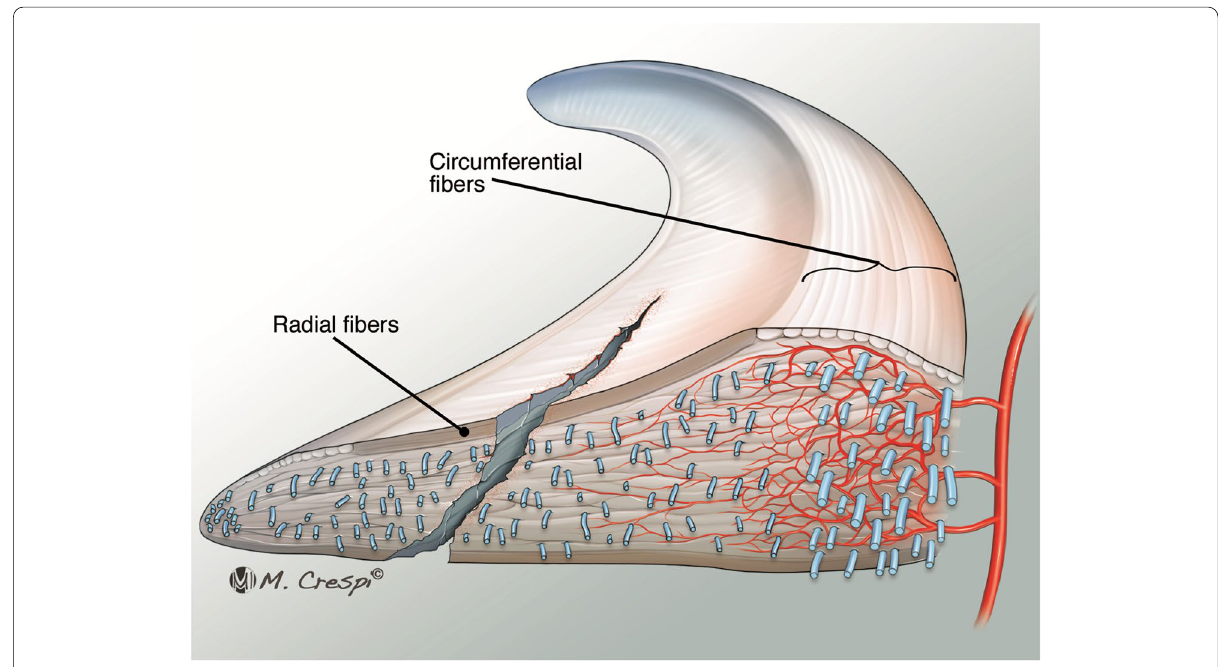
Fig. 1 The meniscal micro-structure with two different orientations of the collagen fibers. The circumferential fibers, creating the so called “hoop stress effect”, and the radial ones, keeping the tissue-structure integrity. In case of vertical longitudinal tears scenario the hoop tensile stress effect is preserved and the circumferential fibers are intact. Differently from that, in case of radial lesion the circumferential fibers are disrupts and the hoop stress effect is